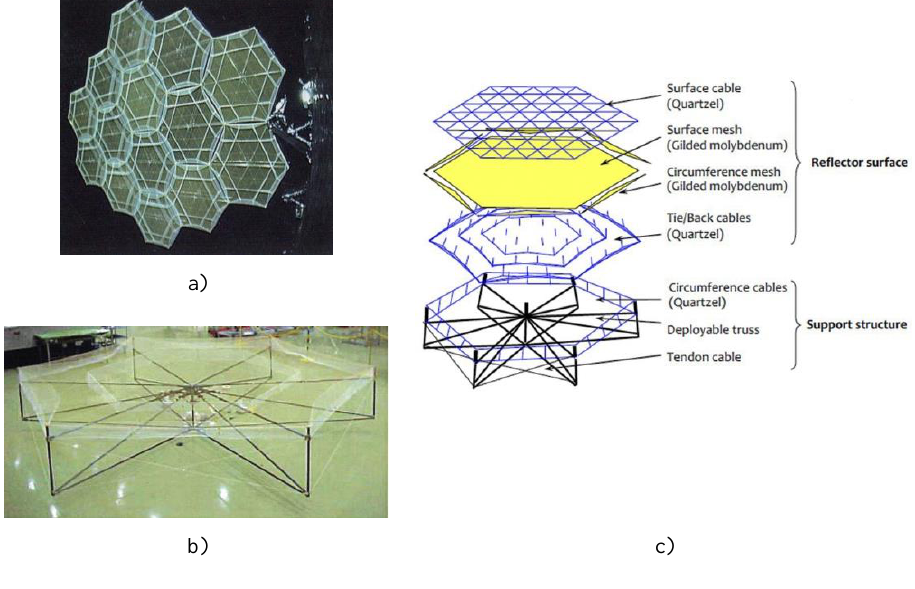
Fig. 5. Truss structure named as “modular